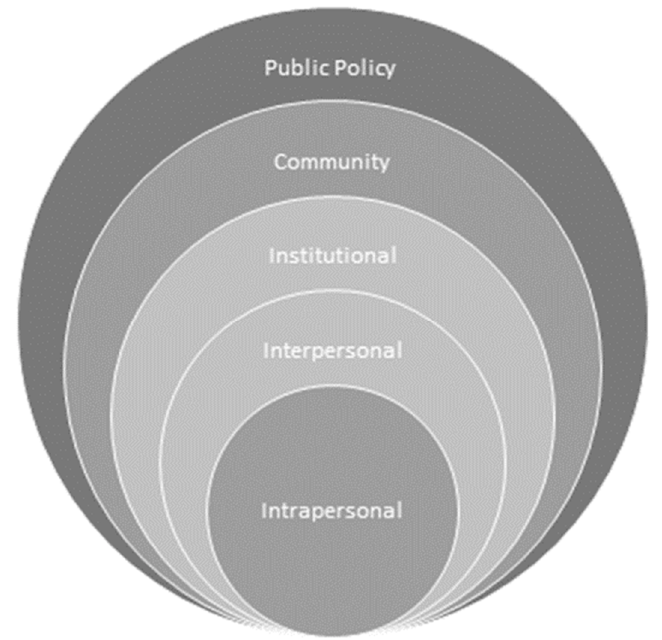
Figure 1. Socioecological framework (adapted from McLeory et al. 1988 [20]) .